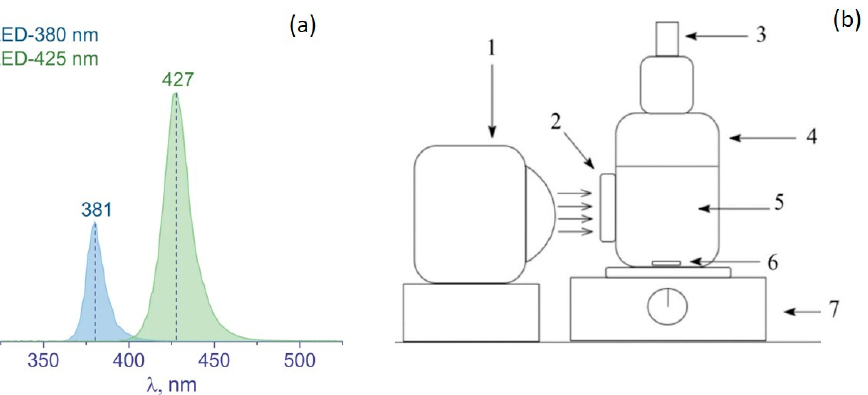
Figure 1. ( a ) Spectra of LEDs with the wavelength at maximum intensity; ( b ) scheme of reaction set-up for photocatalytic study. 1—LED, 2—quartz window, 3—sampler, 4—reactor, 5—reaction mixture, 6—stir bar, 7—magnetic stirrer.